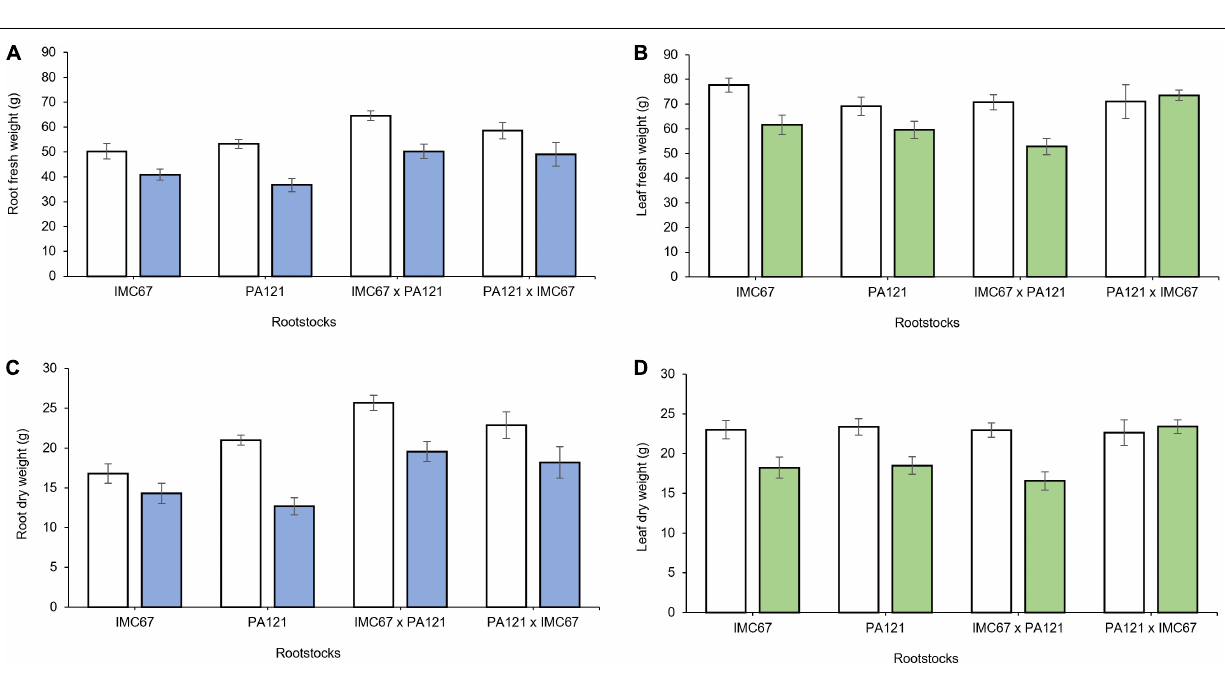
Frontiers in Plant Science |